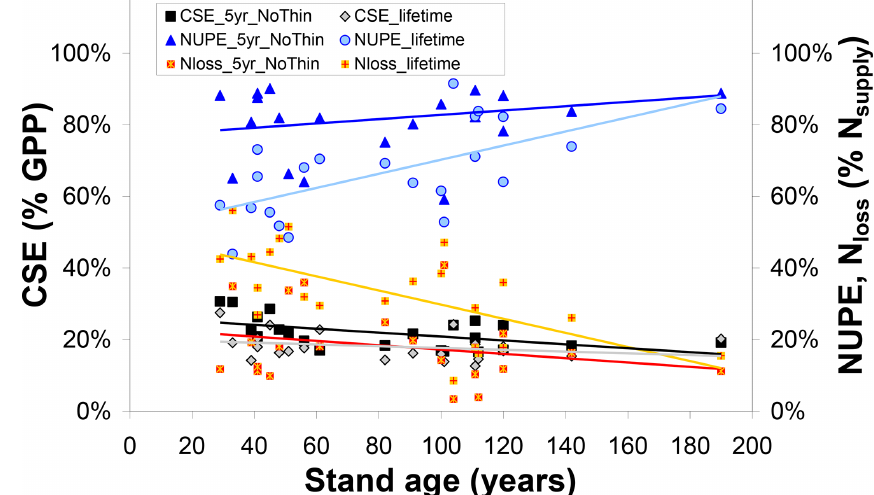
Figure 4. Influence of forest stand age on modelled (BASFOR) C sequestration efficiency (CSE, expressed as % gross primary productivity GPP), N uptake efficiency (NUPE) and the N loss fraction (expressed as % N supply ). Each data point represents 1 of 22 modelled forest sites. CSE and NUPE values are calculated either (i) over the most recent 5-year period including no thinning event around the time frame of the CEIP–NEU integrated projects or (ii) over the whole lifetime of the stands (including all thinning events). See Eqs. (1)–(9) for definitions and calculations of the